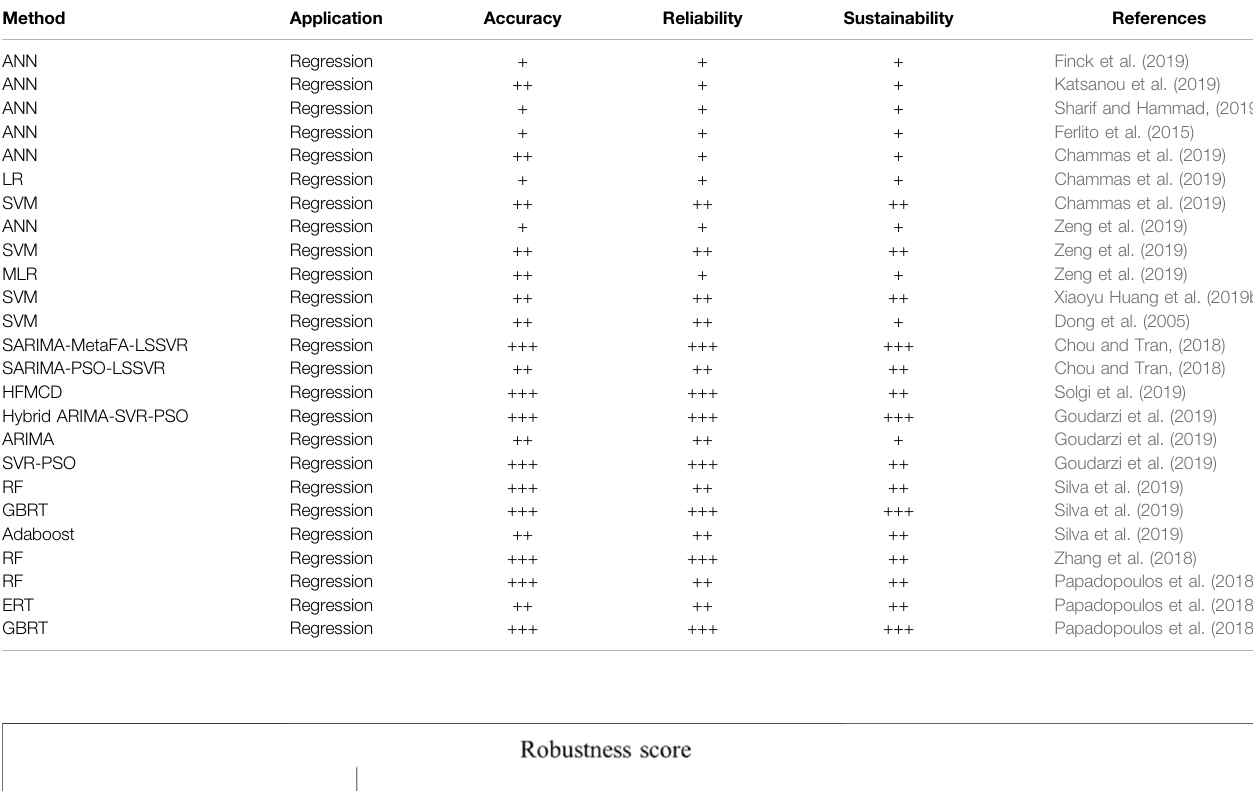
TABLE 5 | The comparison results of methods for BE consumption.